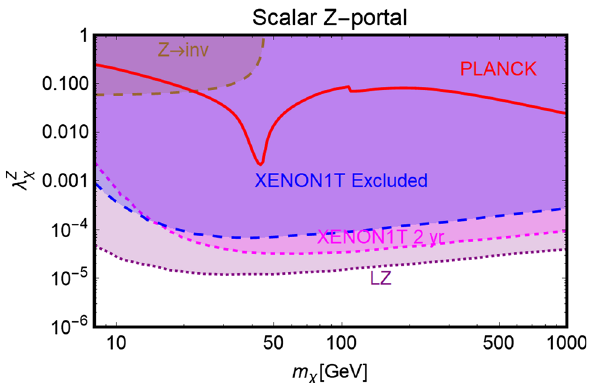
Fig. 6 Combined constraints for Z-portal with scalar DM in the m χ - λ Z χ bi-dimensional plane. Color specifications are the same as Fig. 5, except the fact that now the brown region represents experimentally excluded invisible decay width of Z -boson